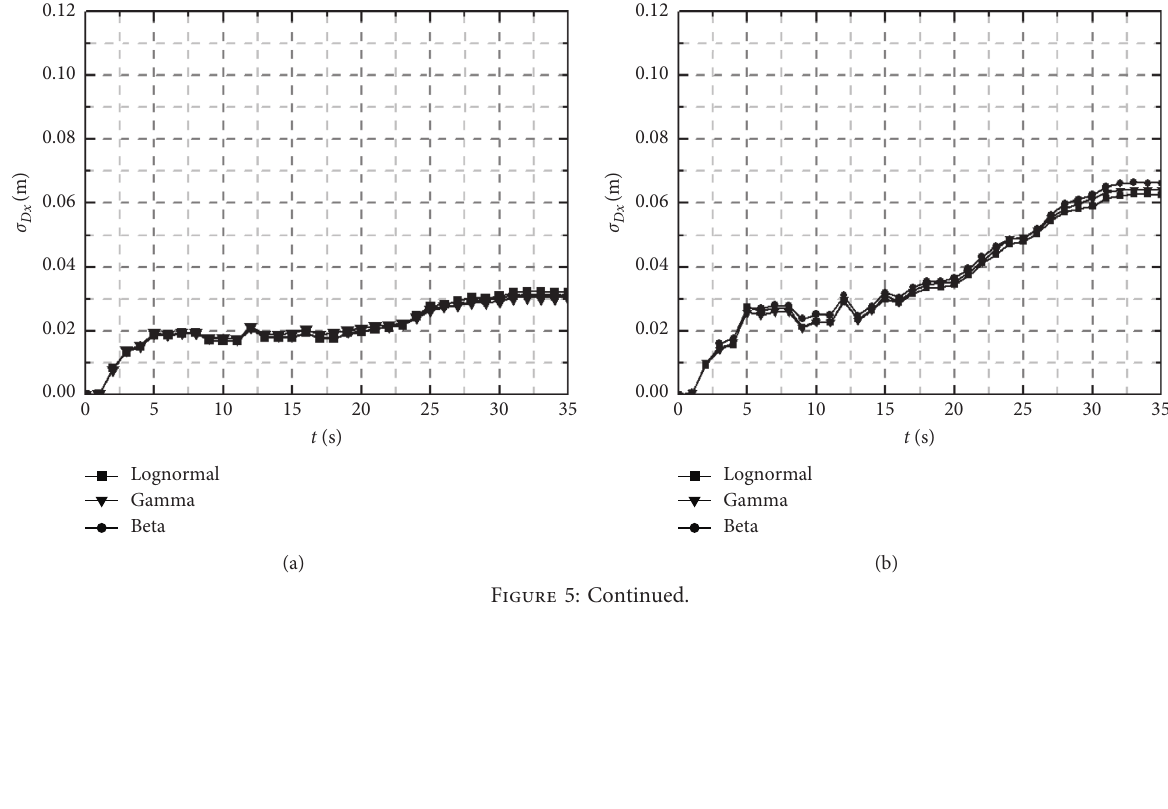
Figure 4: Time history curve of mean ground horizontal displacement ( μ δ x � 6 m and CoV G � 0.3; (c) δ x � 6m and CoV G � 0.5; (d) δ x � 60m and CoV G � 0.1; (e) δ x � 60m and CoV G � 0.3; (f) δ x � 60m and CoV G �